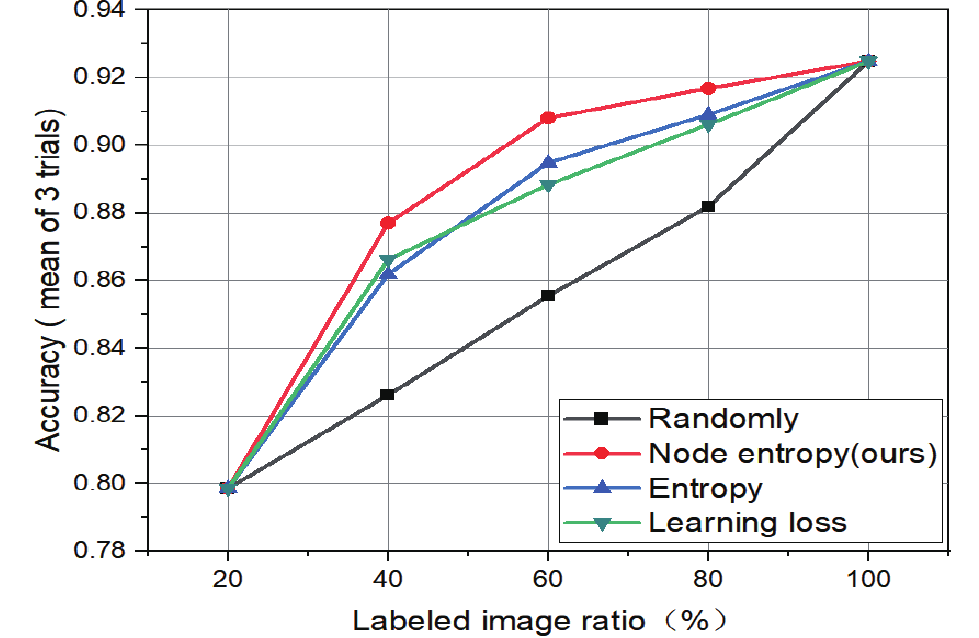
Figure 4. Comparative experiment on AID